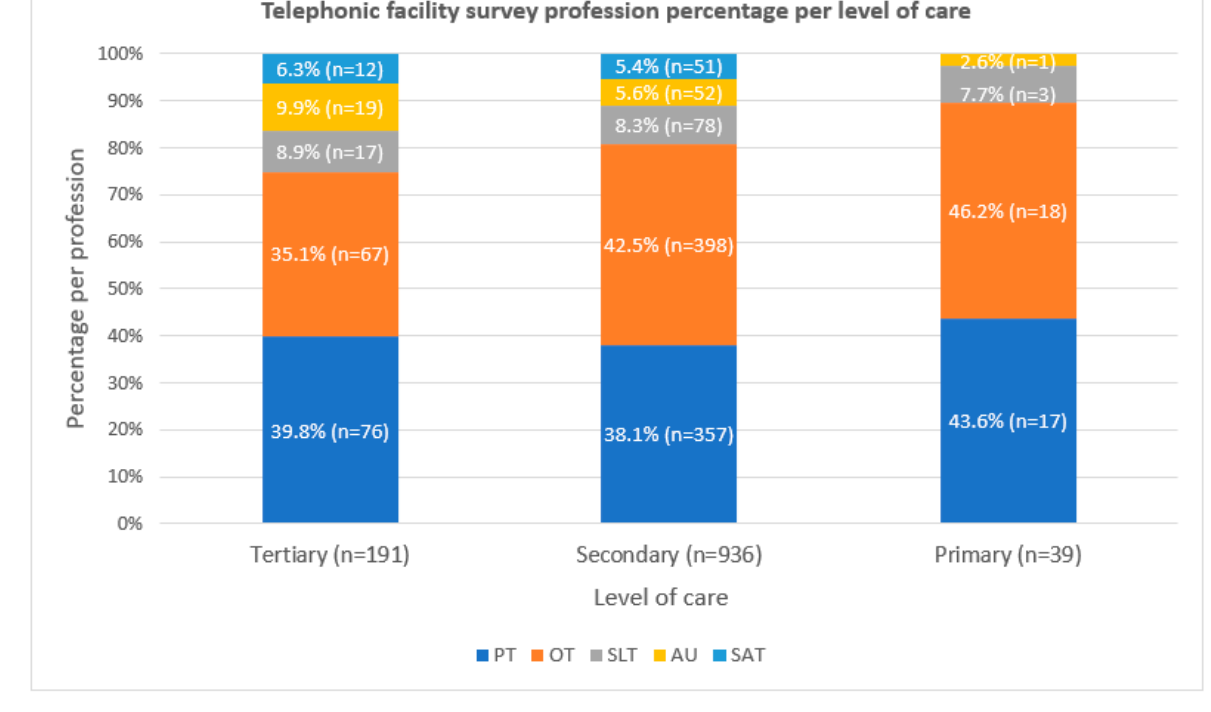
Figure 6. Telephonic facility survey distribution of profession type percentage per level of care. Leg- end: PT—physiotherapy, OT—occupational therapy, SLT—speech–language therapy, AU—audiology and SAT—speech and audiology therapy.